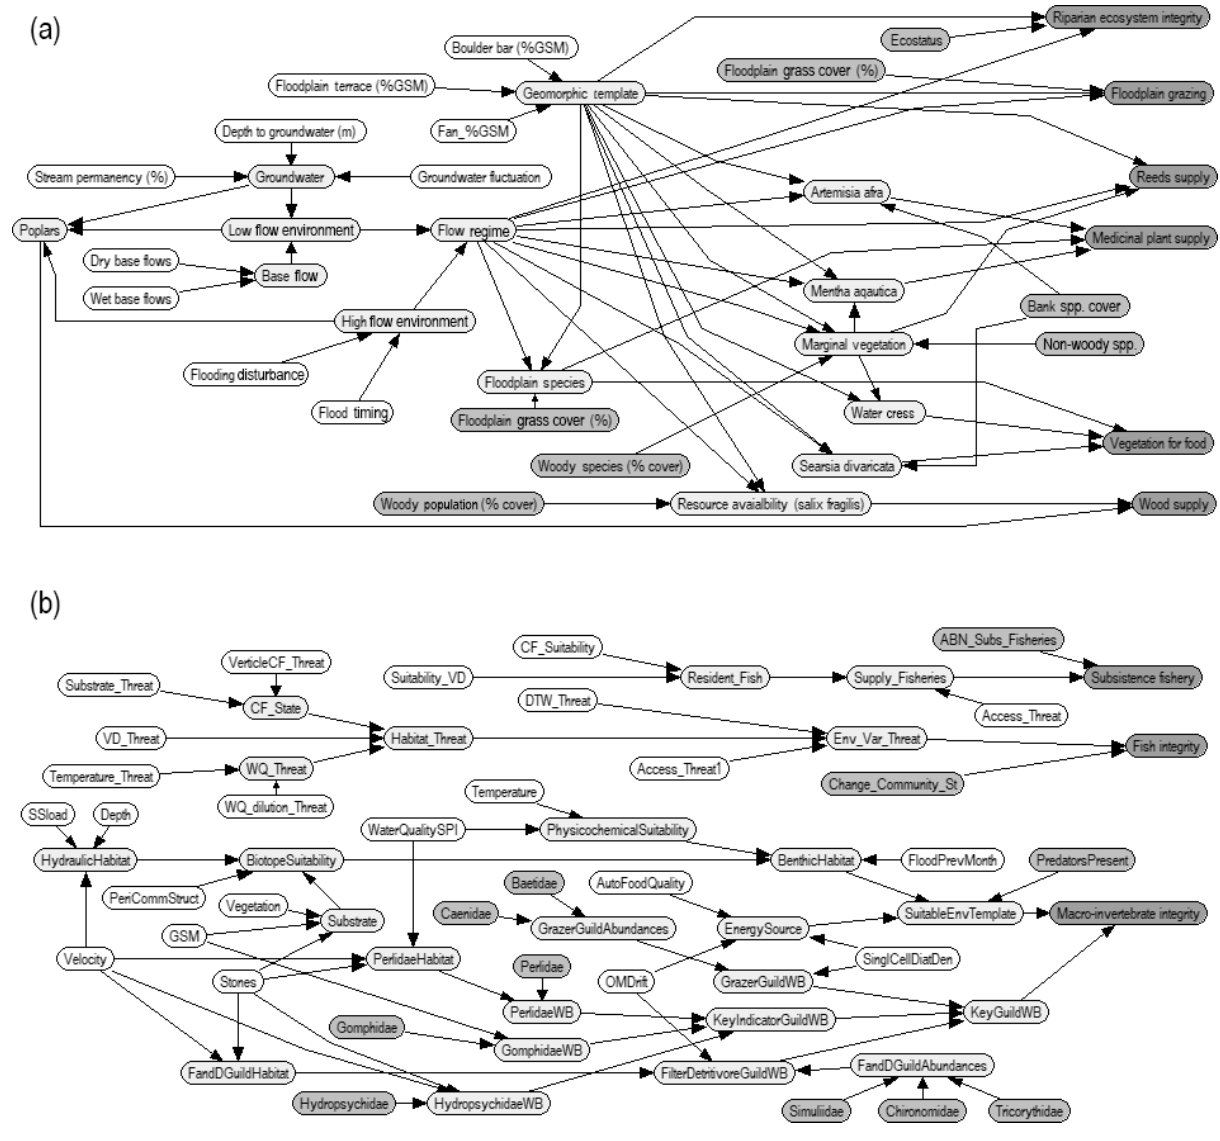
Figure 5. Bayesian network models used in the Senqu River case study to evaluate the risk of flow alterations associated with Phase II of the Lesotho Highlands Water Project to riparian ecosystem integrity and ecosystem service endpoints (a) and instream ecological endpoints and fisheries supply endpoints (b) . White nodes represent input exposure variables, light grey nodes complete the expose leg of the risk assessment, grey nodes represent effect leg of models and dark grey nodes represent endpoints. Working Netica ™ models are provided in the